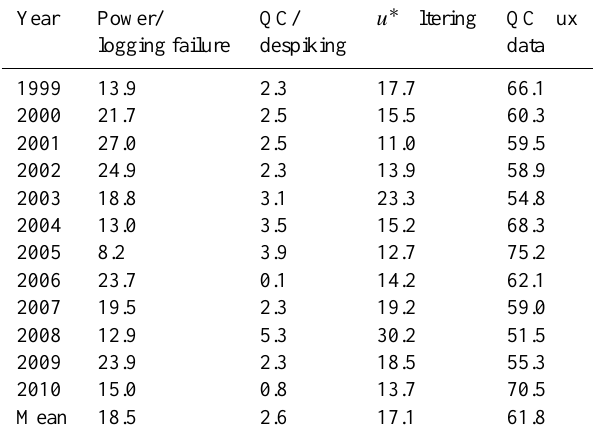
Table 2. Sources of annual data loss of CO 2 flux measurements for the period 1999–2010 at the Straits Inclosure, Alice Holt Forest and quality-controlled (QC) data availability (%).